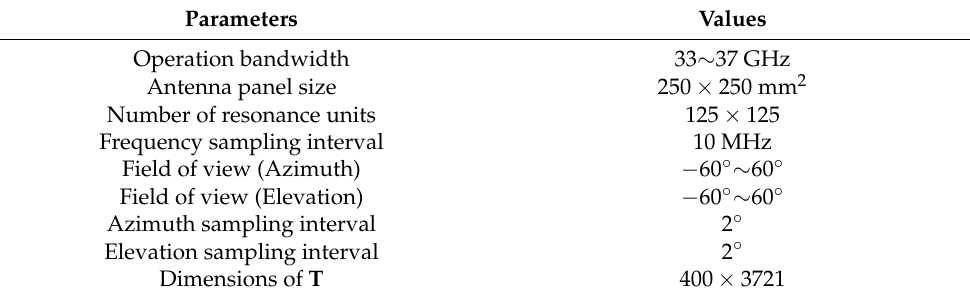
Table 1. Main system parameters of metasurface antenna.